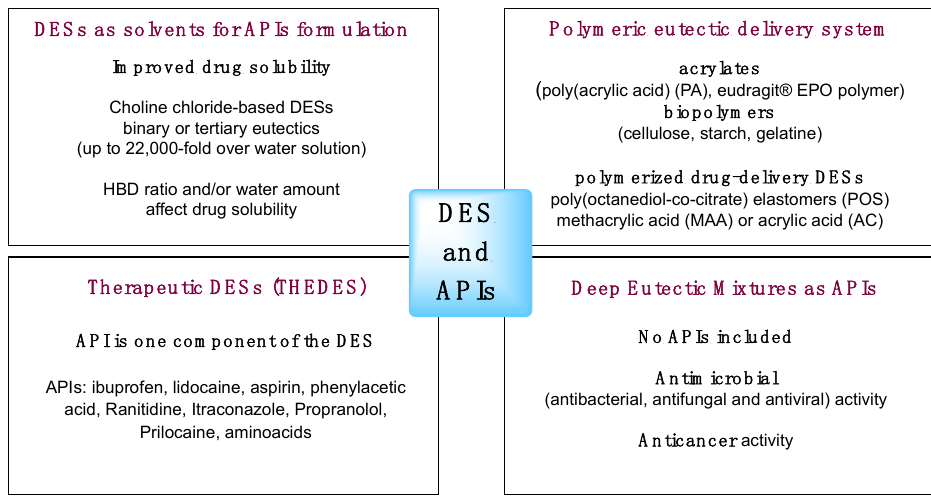
Figure 3. Pharmaceutical applications of Deep Eutectic Solvents: state-of-the-art. DESs represent a safer and biocompatible alternative to organic solvents for the solubilization of poorly water-soluble APIs, in particular for topical formulations.